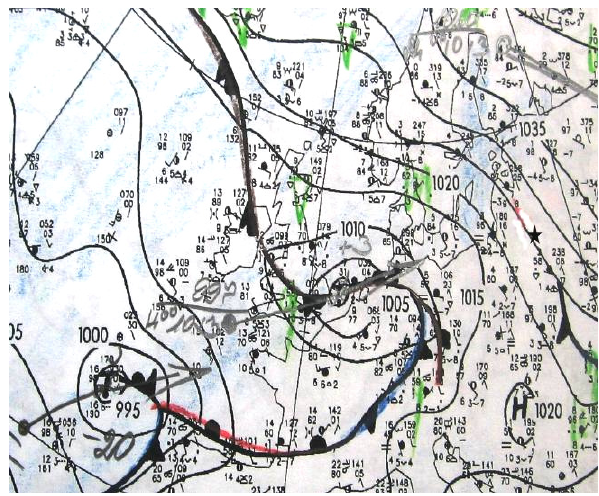
Fig. 4. 14 Oct. 2002 14 h. Time interval 9–10 hours of Fig. 7. 17 Oct. 2002 14 h. No HCRF decease. Cyclones HCRF registration and its decrease (–23 imp/h) approaching Vilnius